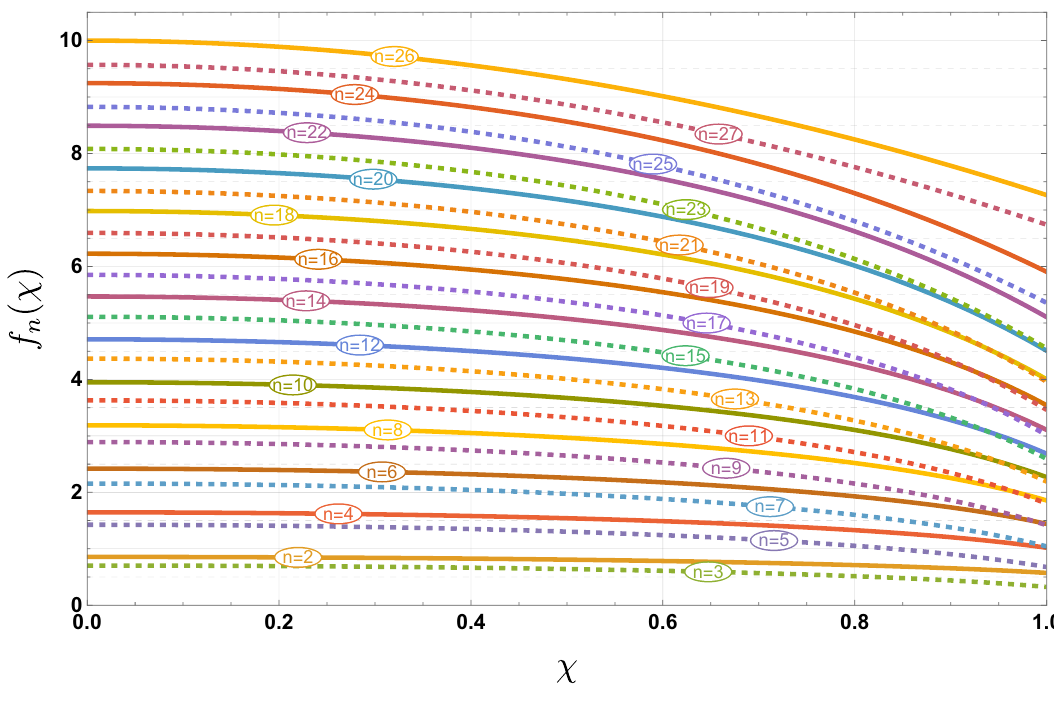
Figure 1 . The function f n ( χ ) determining the six-derivative corrections to the multipoles in (4.6). Odd and even multipoles are given by dashed and solid lines, respectively.